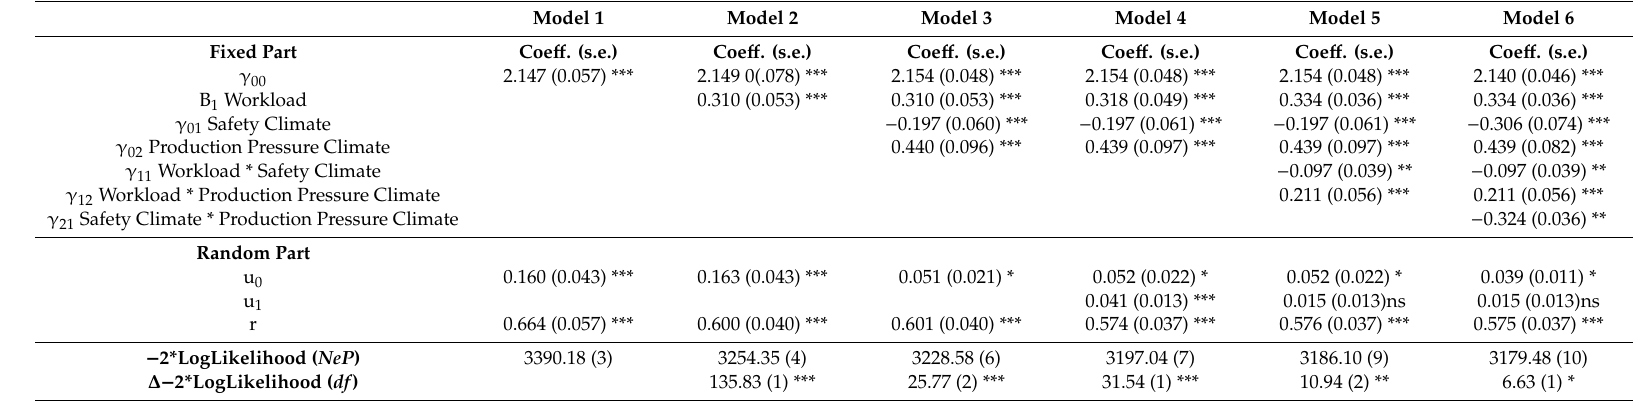
Table 2. Estimated Coe ffi cients from the Tested Multilevel